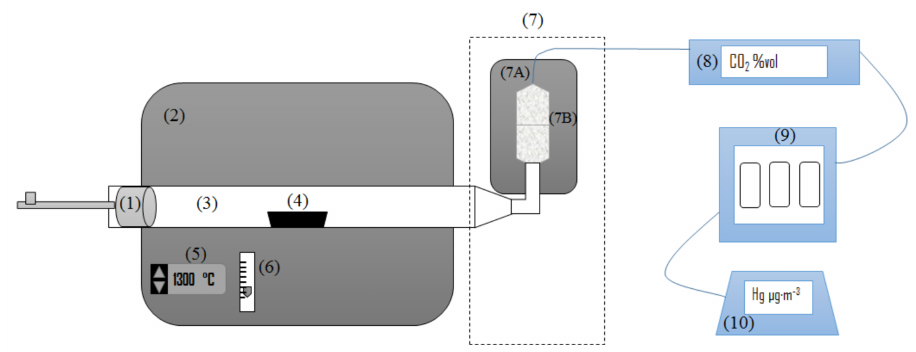
Figure 1. Test stand schematic: (1) metal rod for sample transport; (2) tube furnace; (3) quartz tube; (4) coal sample; (5) temperature regulator; (6) rotameter; (7) adsorption system; (7A) sorbent heater; (7B) glass reactor with sorbent; (8) carbon dioxide analyser; (9) set of impingers; (10) mercury analyser